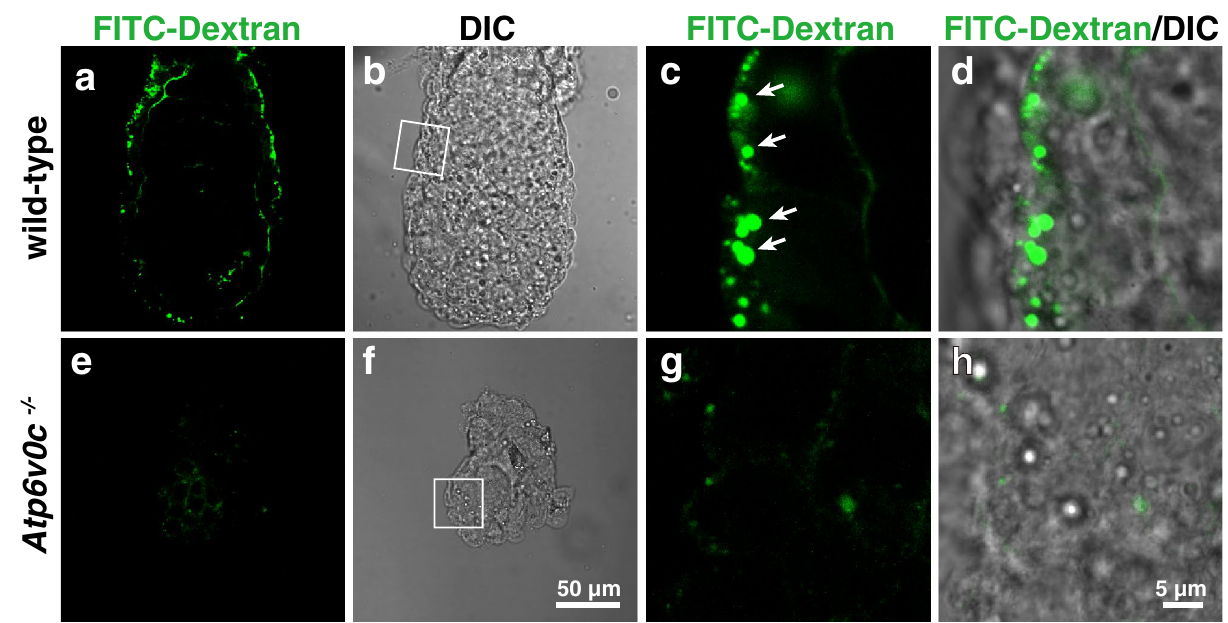
Figure 6. Endocytosis of FITC dextran in VE cells. E5.5 embryos were in utero labelled with fluorescent dextran. The embryos were fixed and observed under a confocal microscope. Wild-type and heterozygous embryos could internalise fluorescent dextran (arrows) via endocytosis ( a to d , arrows) (n = 15), whereas the fluorescent signals in Atp6v0c mutant embryos ( e to h ) (n = 3) were under the detection level. Scale bars are indicated in each